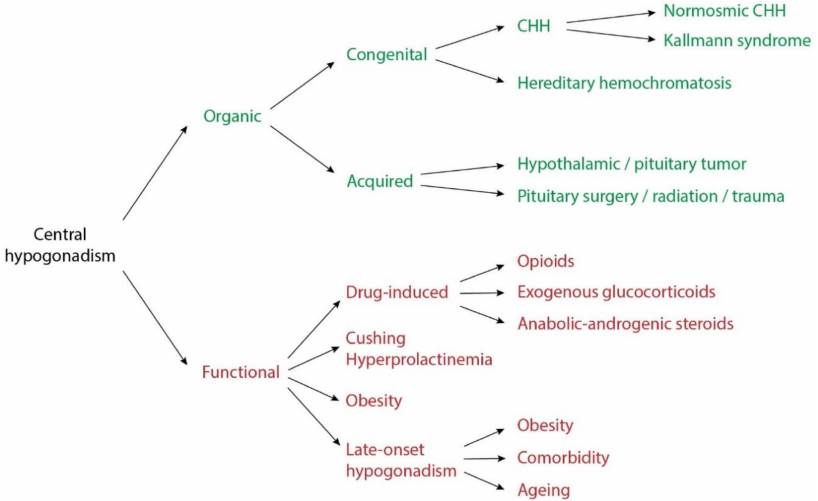
Figure 1. Overview of the different causes of central hypogonadism. CHH: congenital hypogo- nadotropic